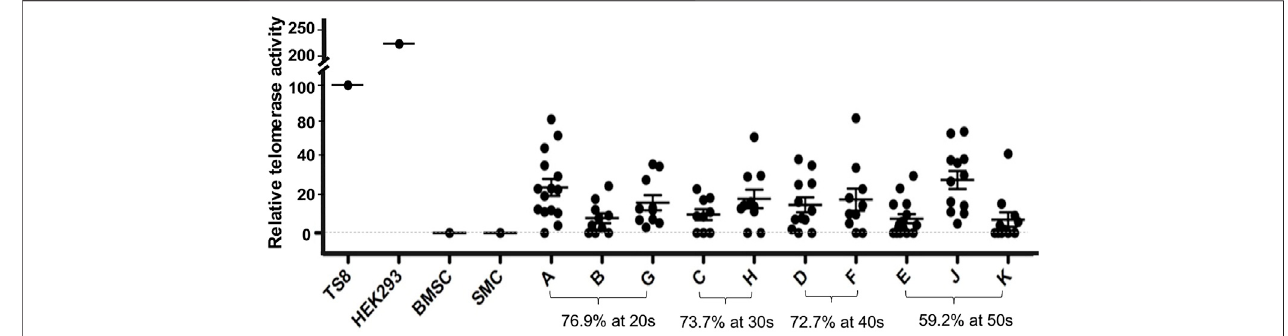
FIGURE1| Distribution ofhumanUSCs TA+ indifferentagegroups. MostUSCs(76.9 – 72.7%)retainedtelomeraseactivity indonorsat age20 – 40 yearsofage,but the ratio of USCs TA+ signi fi cantly dropped to 59.2% in the donors over 50 years. Cell extracts were prepared from 2 × 10 5 cells and assayed for telomerase activity, accordingtothe manufacturer ’ sinstructions (Telo TAAGG ELISAPLUS kitRoche). TS8wasprovided asarepresentative positivecontrollysate prepared from HEK-293 cells.BMSC;humanmesenchymalstromalcellsofbonemarrow,SMC;smoothmusclecellsascontrols,andA,B,C,D,E,F,G,H,J,K;individualUSCclonesfrom different aged healthy individuals (20 – 50 s), at passage 2 (p2). RTA is the percentage (%) of TS8 (internal positive control) after being normalized.